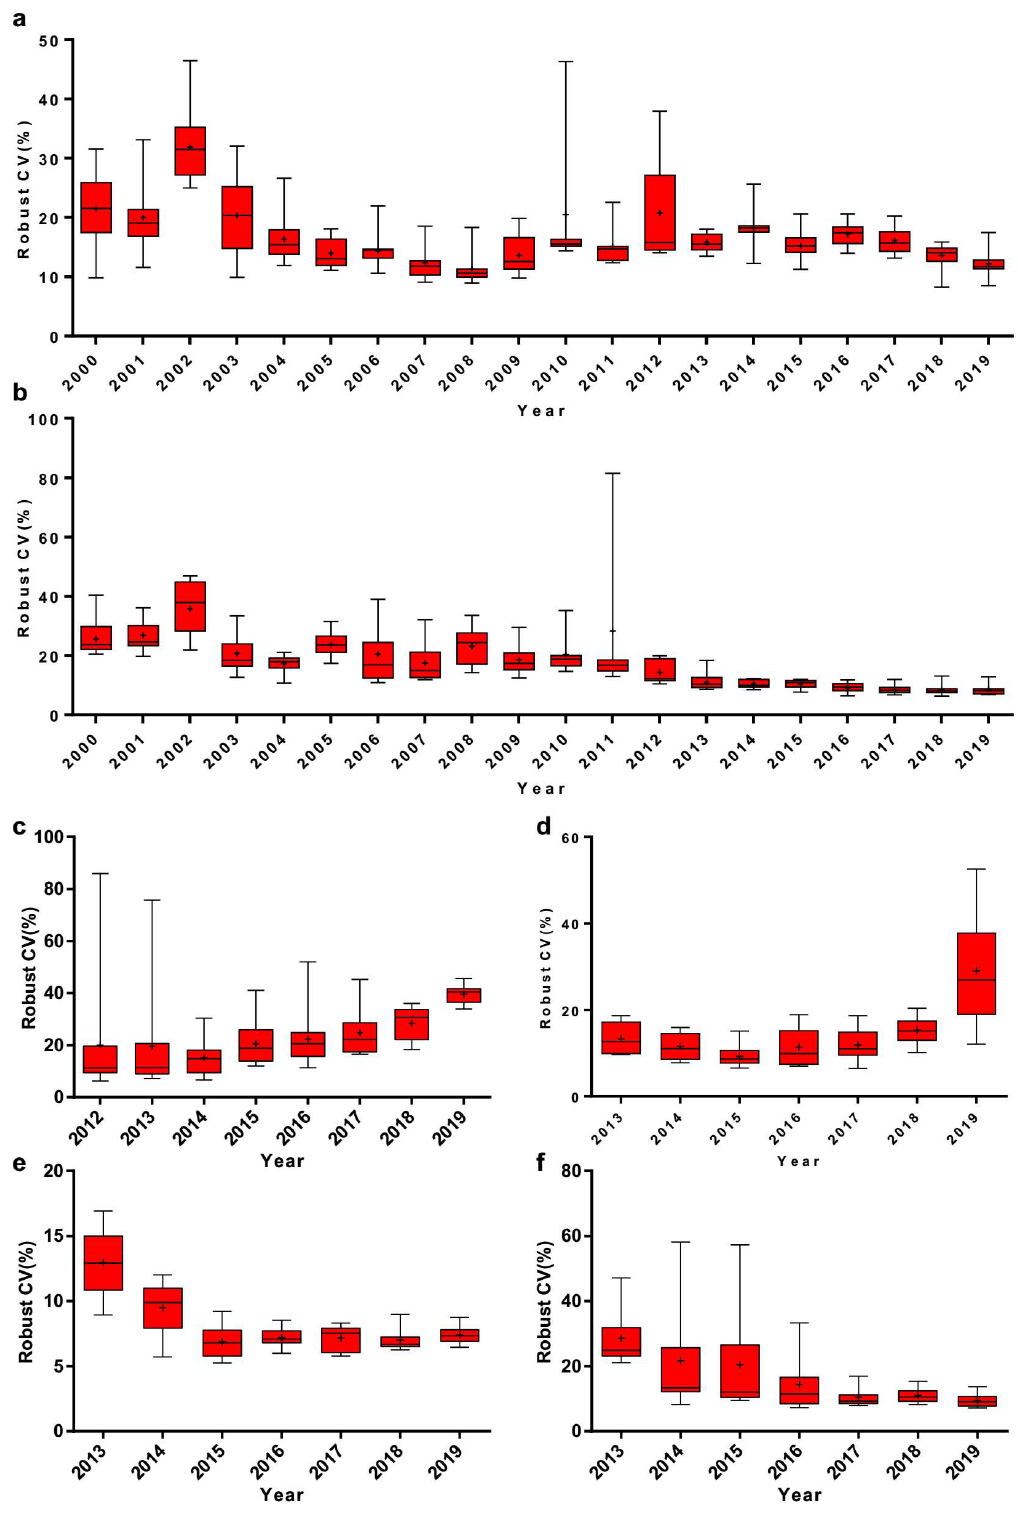
Figure 1. Annual variation of robust coe ffi cient of variation (CV) of ( a ) phenylalanine (Phe), ( b ) thyroid stimulating hormone (TSH), ( c ) glucose-6-phosphate dehydrogenase (G6PD), ( d ) 17-alpha-hydroxy progesterone (17-OHP), ( e ) Phe (MS / MS) and ( f ) free carnitine (MS / MS). Box-and-whiskers plots represent the median and interquartile range (IQR) with whiskers ranging between the min and max; + indicates the mean of robust CV. n = 10 or 15 ( n equals to the number of distributed DBS per year).